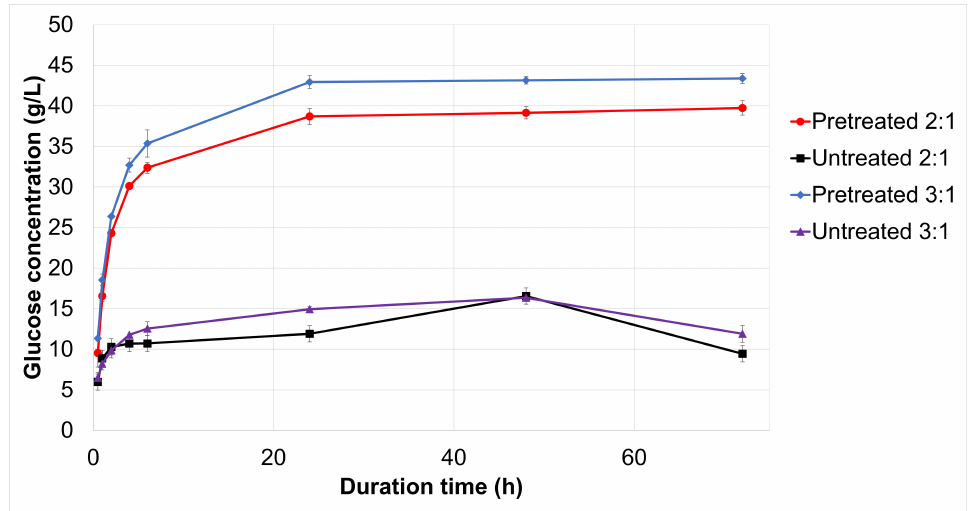
Figure 4. Glucose concentration for untreated and pretreated corn stover. Experiments were per- formed for two different ratios of CTec2:HTec2